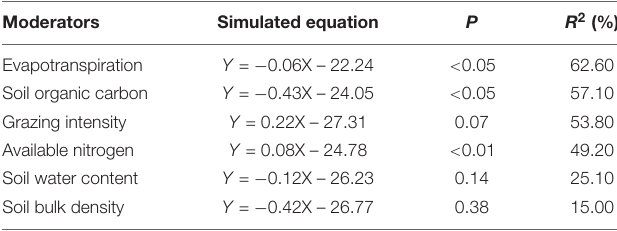
TABLE 3 | Response of δ 13 C value of alpine meadow to climate and soil physical and chemical properties.